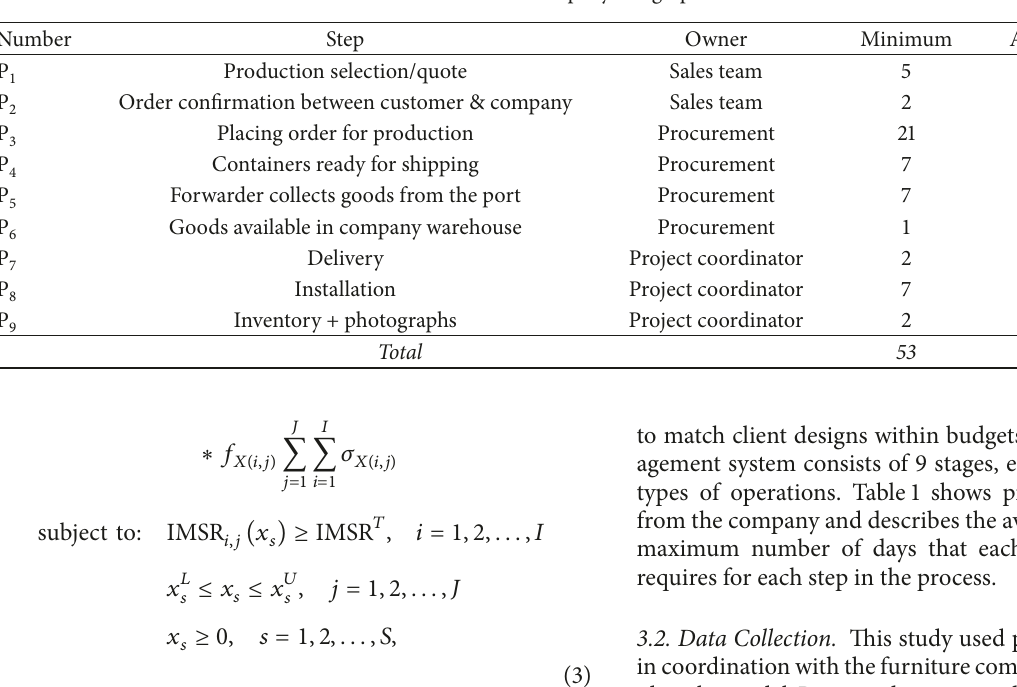
Table 1: Company design